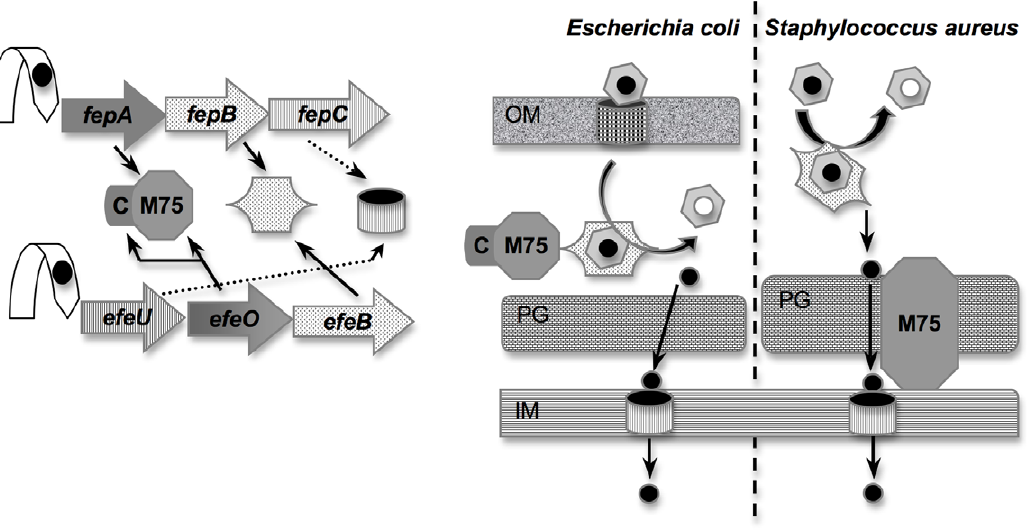
Figure 1. General organization of the EfeUOB and FepABC systems. This scheme represents both the genetic (left part of the figure) and envelope organization (right part of the figure) of the S. aureus fepABC and E. coli efeUOB . Orthologous proteins are shown with the same pictogram and the same color. Both operons are regulated by iron loaded Fur repressor. Fur repressor is represented by an arrow with a black circle for iron; FepB and EfeB by a hexagone; FepC and EfeU by a hollow barrel; EfeO by a N-terminal square corresponding to the cupredoxin domain (C) and a C- terminal hexagone corresponding to the M75 peptidase domain; FepA which has only a M75 peptidase domain by a hexagone; heme is represented by a ring and a black circle for iron; HasR, the outer membrane receptor for heme is represented by a barrel; OM for outer membrane; PG for peptidoglycan; IM for inner membrane. Their putative function and cellular localization are shown in the right part of the figure.